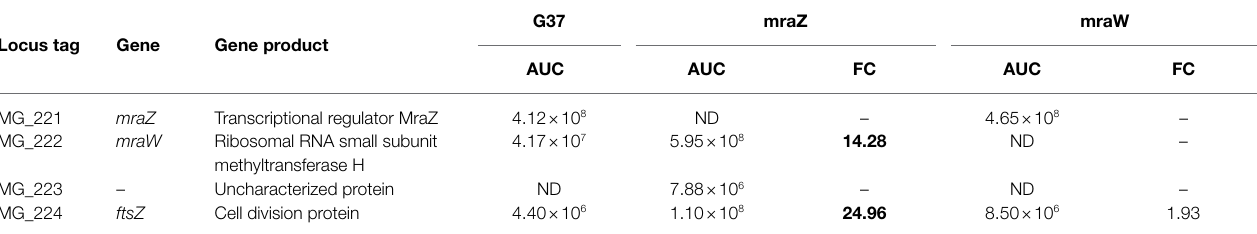
TABLE 2 | Comparative analysis of the abundance of cell division proteins in the wild-type strain and the mraZ and mraW mutants by stable isotope labeling by amino acids in cell culture (SILAC).